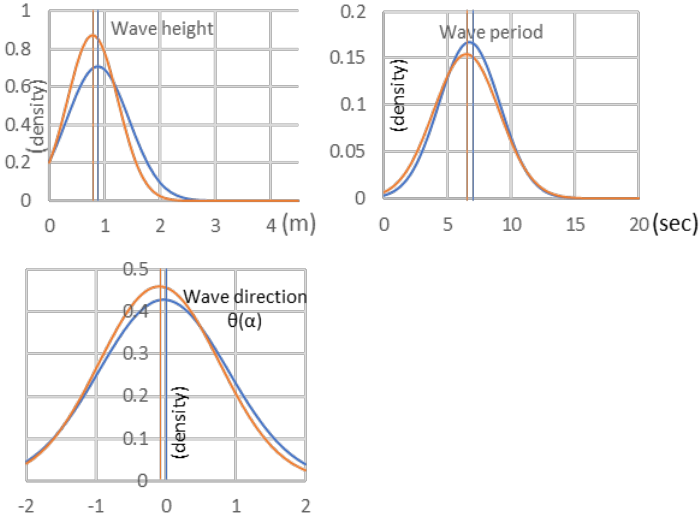
Figure 11. Density function plots for the observed and simulated wave height (m), wave period (s) and wave direction (dimensionless transformed) respectively, in the time period from: 1 April 2013 to 30 June 2016. Blue curves correspond to observed data and red curves correspond to simulated data. Similarly, blue and red vertical lines correspond to the means of the observed and simulated data, respectively.